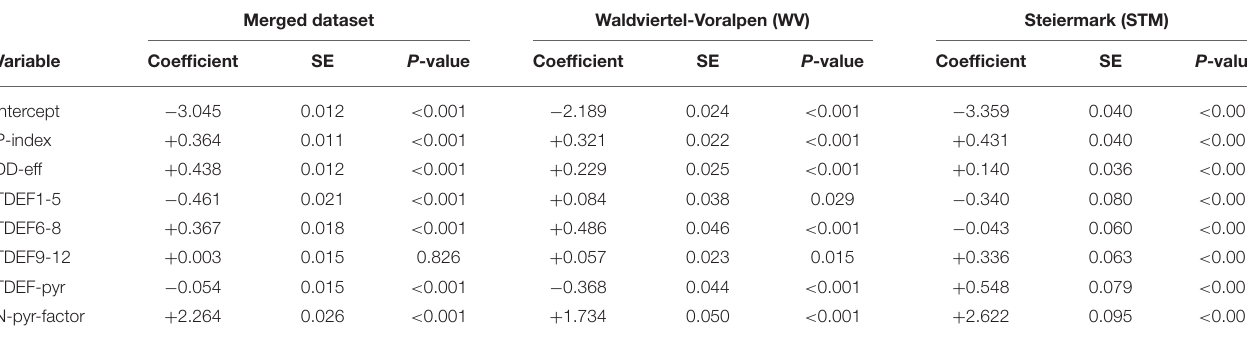
TABLE 6 | Binary logistic regression models for predicting the absence/presence of bark beetle attack (N-yr-factor) for ÖBf forest enterprises: merged dataset (AUC = 0.720; R 2 N = 0.137), “Waldviertel-Voralpen” (WV) (AUC = 0.723; R 2 N = 0.157), and “Steiermark” (STM) (AUC = 0.720; R 2 N = 0.132) with regard to the observation period